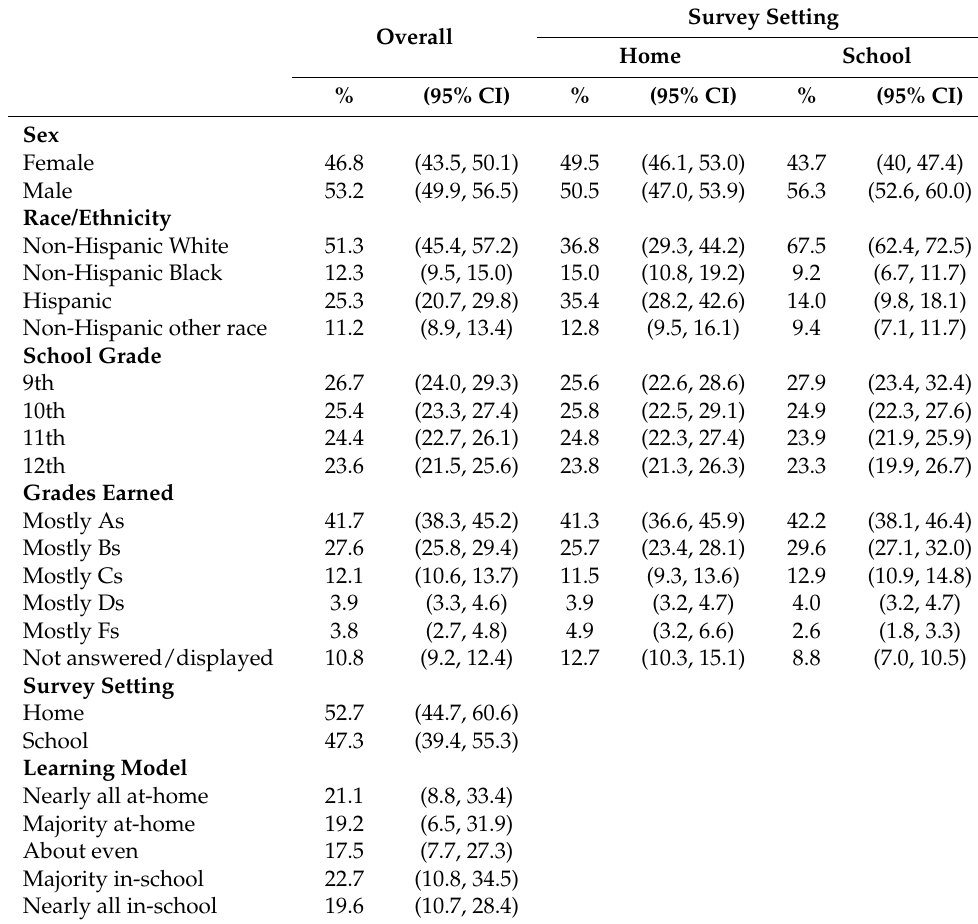
Table 1. Characteristics of U.S. high-school students overall and by survey setting (unweighted n =